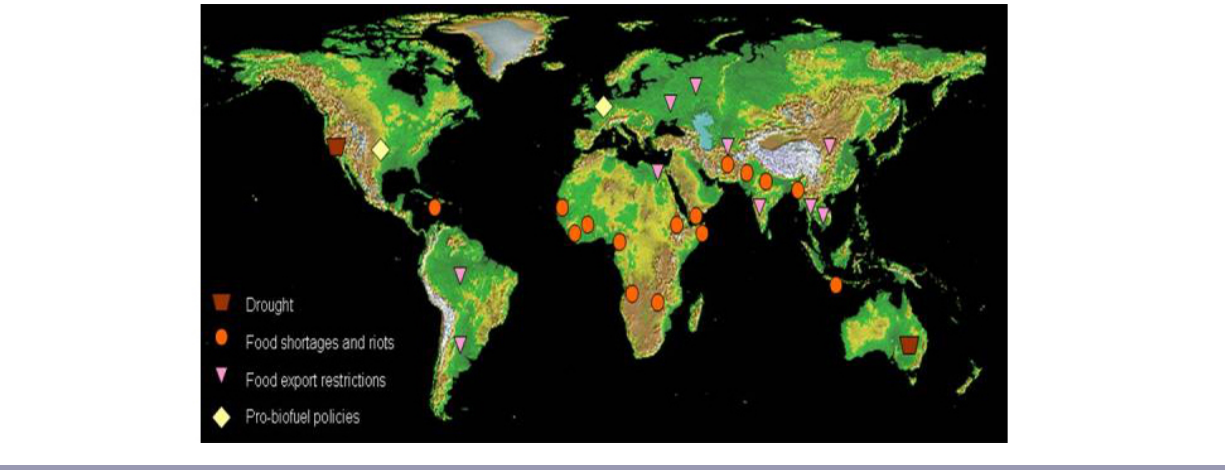
Fig. 2. The interactive effects of global drivers and national-scale policy responses led to the food price crisis of 2007 to 2008 with origins and impacts in far removed regions and sectors of the globe. The crisis was exacerbated by droughts in key production